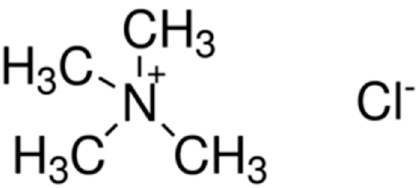
Figure 3. Molecular Structure of tetramethyl ammonium chloride.